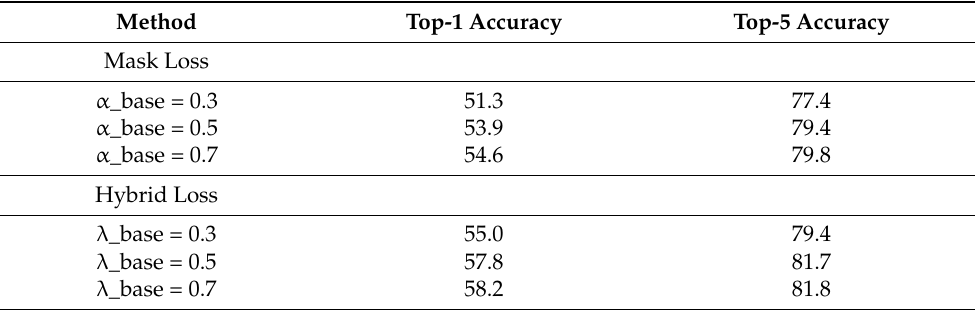
Table 4. The comparison obtained representation of HARL framework using mask loss and hybrid loss objective. We report Top-1 and Top-5 (in %) accuracy on ImageNet linear evaluation from 100 epochs pre-trained ResNet-50 backbone on ImageNet 1000